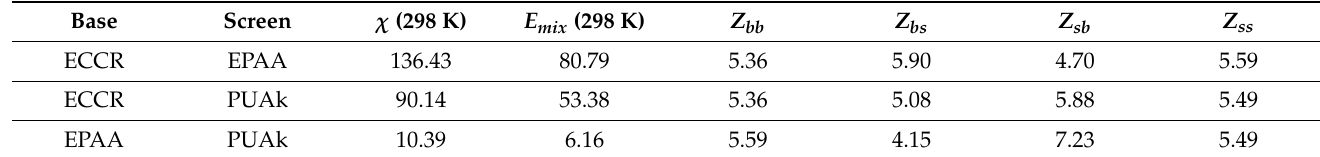
Table 8. Blend of the interacting systems: energies are in kcal mol − 1 .